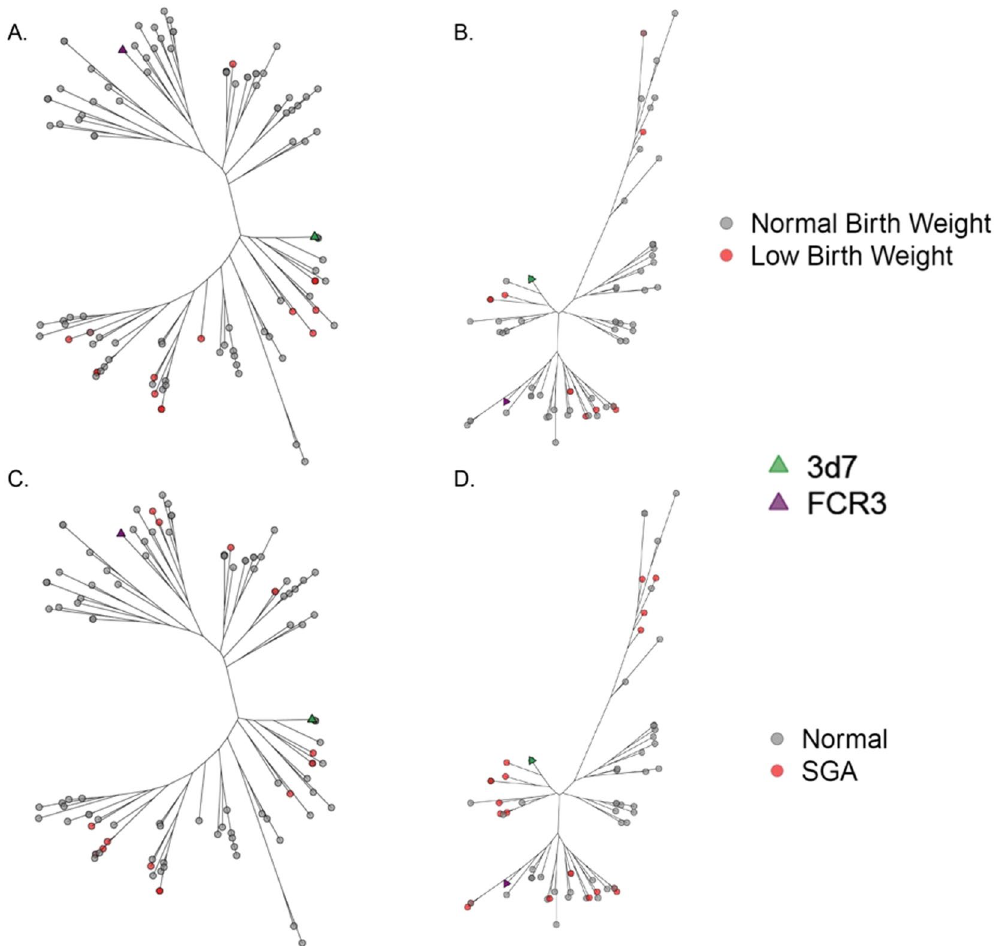
Figure 5. Maximum-likelihood phylogenetic trees of ID1-DBL2x variants by low birth weight (LBW) and small-for-gestational age (SGA). Panel A and C show data for Malawi for LBW and SGA, respectively. Panels B and D show data for Benin for LBW and SGA, respectively. All trees were bootstrapped 1000x and bootstrap values > 80 were used as cutoff points for significant branch differentiation. LBW was defined according to World Health Organization’s criteria as infant with a birth weight of less than 2500 grams. 3D7 (green) and FCR3 (purple) were detected in both countries. Majority of the LBW variants (red) in Malawi were present in the 3D7-like clade (green) whereas in Benin, the LBW variants were more evenly distributed between 3D7-like (green) and FCR3-like (purple) clades. SGA was defined as infant with a birth weight below the 10 th percentile for babies of the same gestational age at delivery. 3D7 (green) and FCR3 (purple) were detected in both countries. SGA variants (red) clustered more readily in 3D7-like clade in Malawi whereas in Benin, the distribution was more even between 3D7-like and FCR3-like clades. We also identified four SGA variants clustered in clade